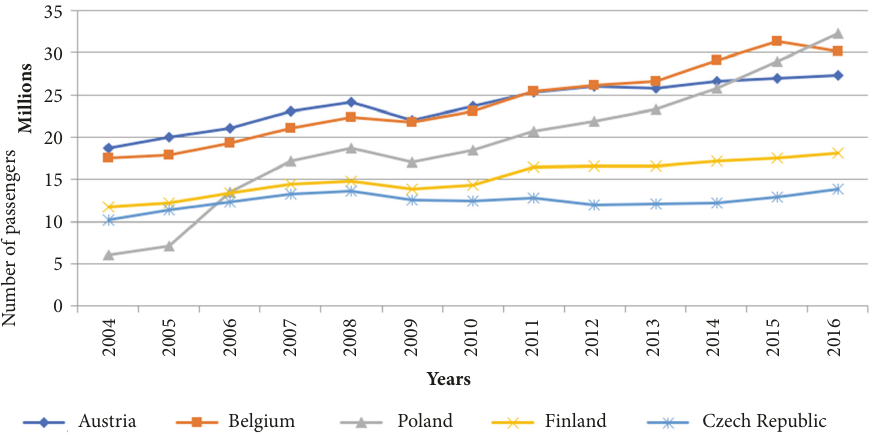
Figure 1: Number of passengers over the course of the analyzed years.